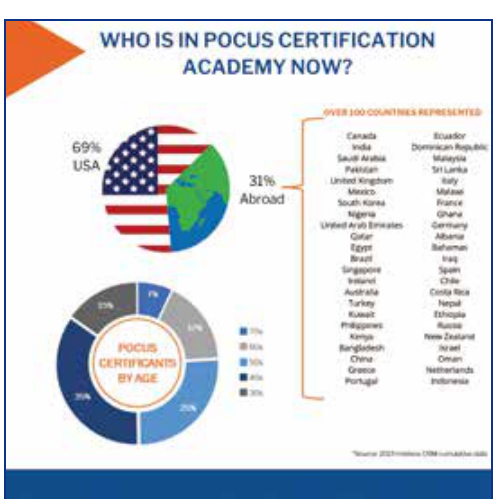
Figure 1 PCA POCUS Resource Library Figure 2 PCA Demographics Countries and Age